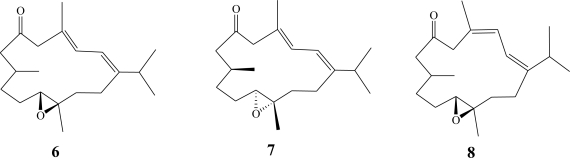
Structures of 6–8.